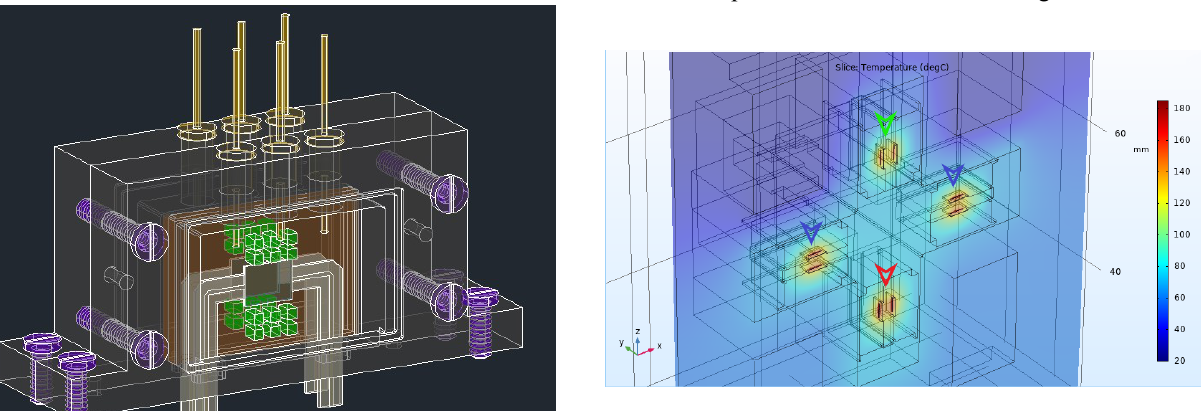
Heat Sink, the heat distribution will be that shown in fig. 11; being placed at different distances from the cold plate, vertical and horizontal solid state amplifiers experience different temperatures which are shown in fig. 12.